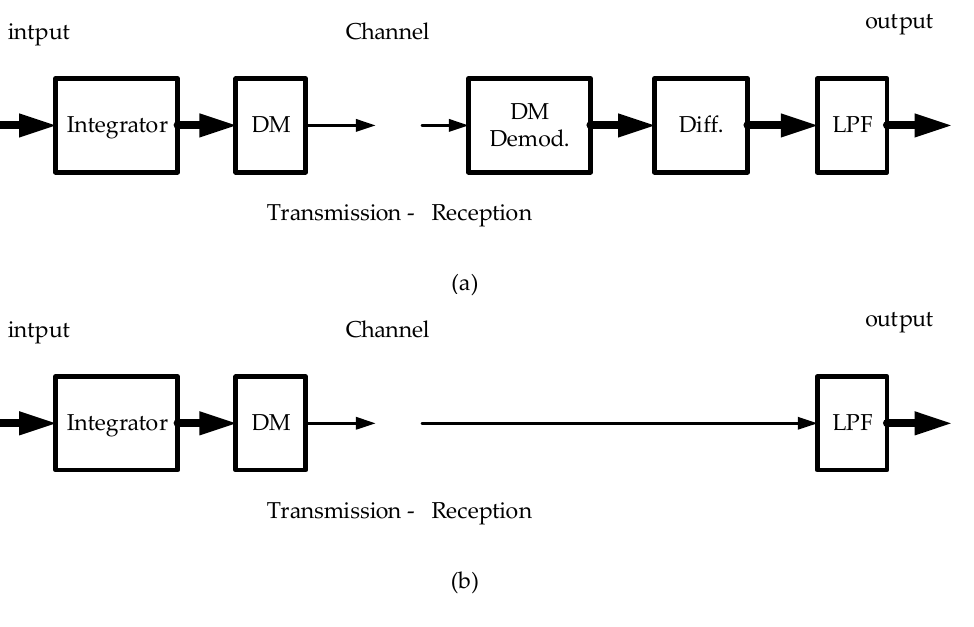
Figure 5. Sigma-delta modulation (SDM): ( a ) derivation of SDM; ( b ) SDM system.